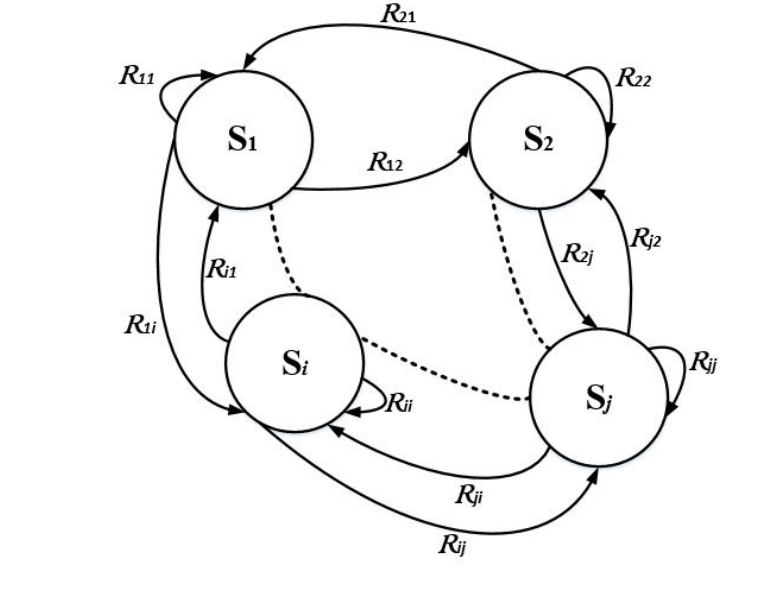
Figure 1. State diagram of the fuzzy finite state